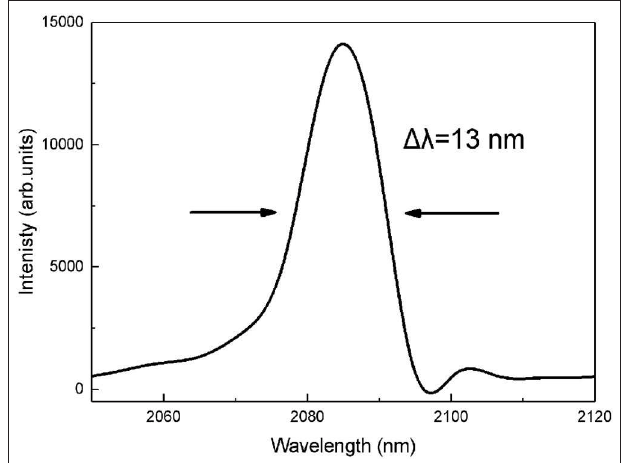
FIGURE 3 | The emission spectrum of QML Tm,Ho: CaYAlO 4